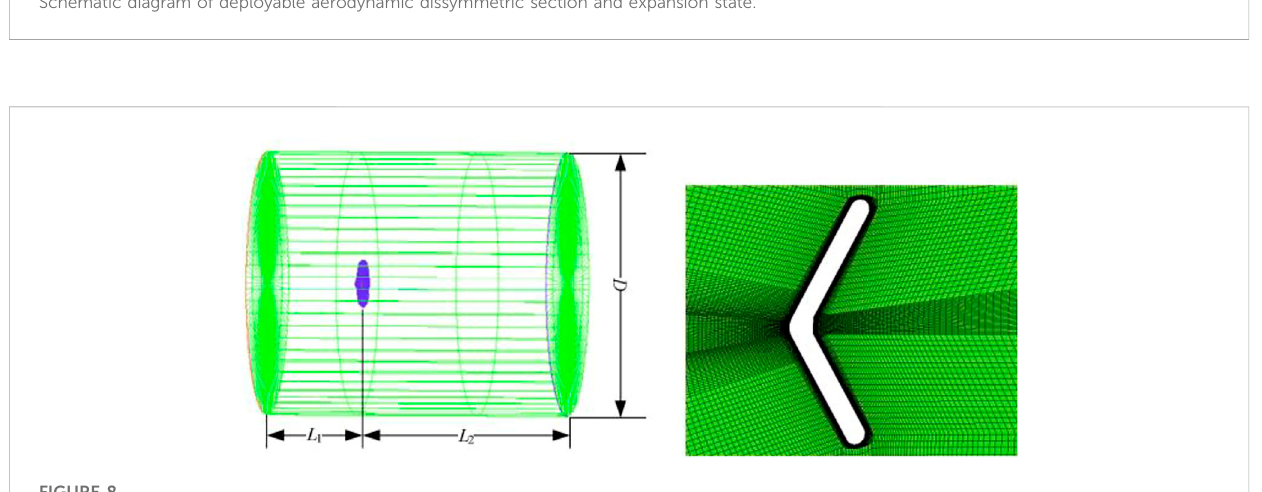
FIGURE 8 Flow fi eld model and grid.